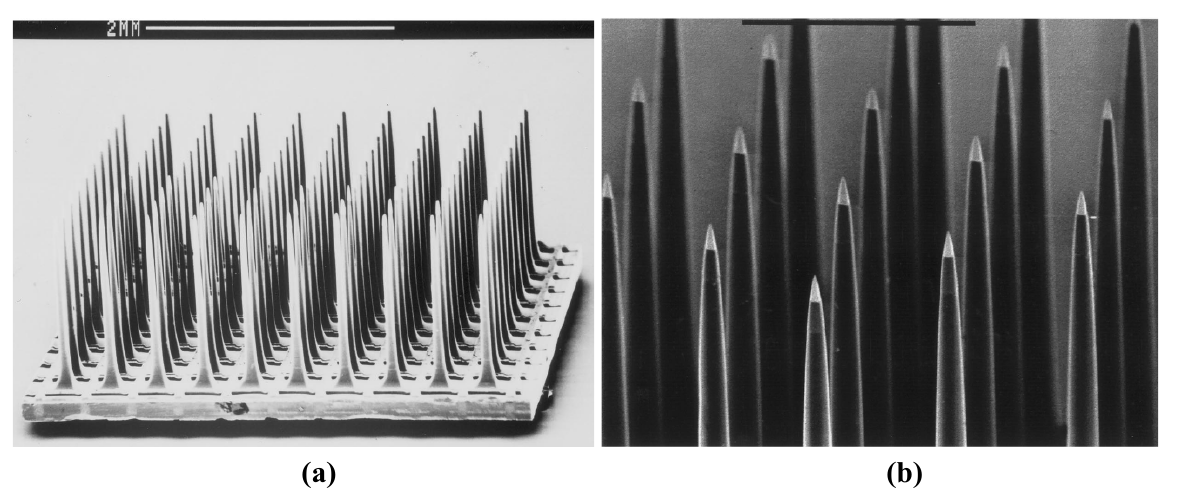
Figure 7. SEM micrograph of: (a) The Utah array. (b) The insulation coated electrodes with exposed platinum tips. Reprinted from [93], with permission from